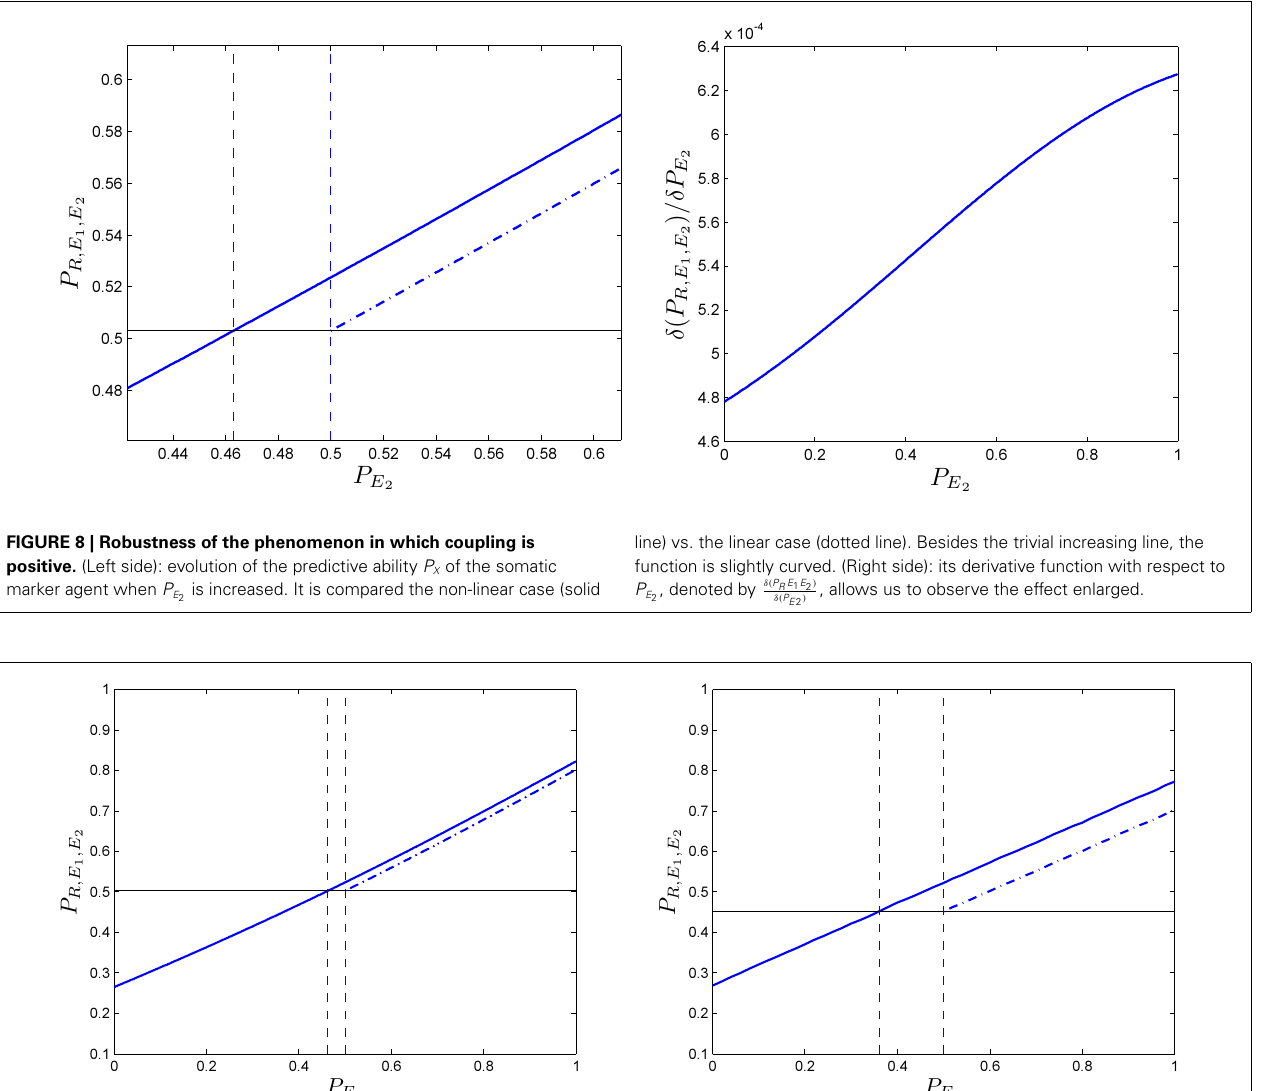
(Right side): it can be noticed that the two-dimensional example FIGURE 9 | One-dimensional (left column) and two-dimensional requires lower values of P E to obtain similar outcomes than in the (right column) phenomena of positive coupling. (Left side): in the 2 = 0.1, first plot, the predictive ability P RE is represented ( P E one-dimensional one. All values have been obtained after 50,000 1 E 2 1 P R = 0.8).The linear case in dotted line, the non-linear case in solid line. simulation